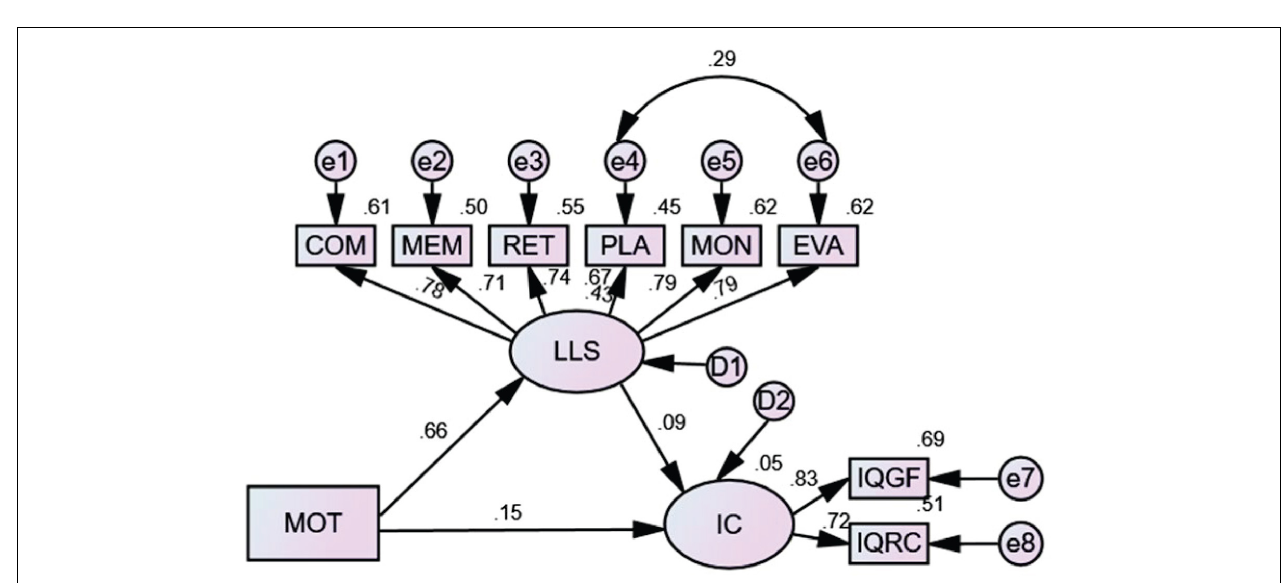
FIGURE 1 | Structural model of the relationships between motivational strategies, language learning strategies and literal comprehension. LLS, Language learning strategies; COM, comprehending; MEM, memory; RET, retrieval; PLA, planning; MON, monitoring; EVA, evaluating; MOT, motivational strategies; LC, literal comprehension; LQGF, literal questions in gap-filling; LPC, long passage comprehension; LQRC, literal questions in reading comprehension.